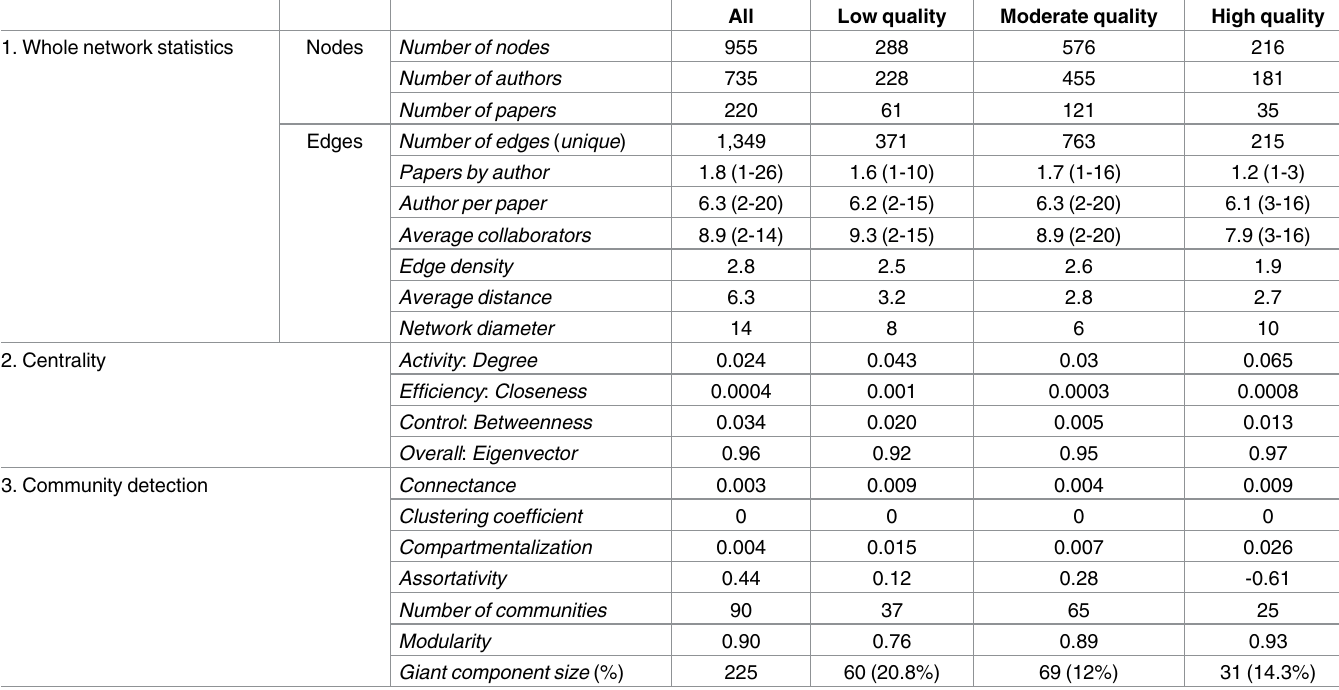
Table 1. Summarystatistics for the co-authorship networks based on methodology quality.